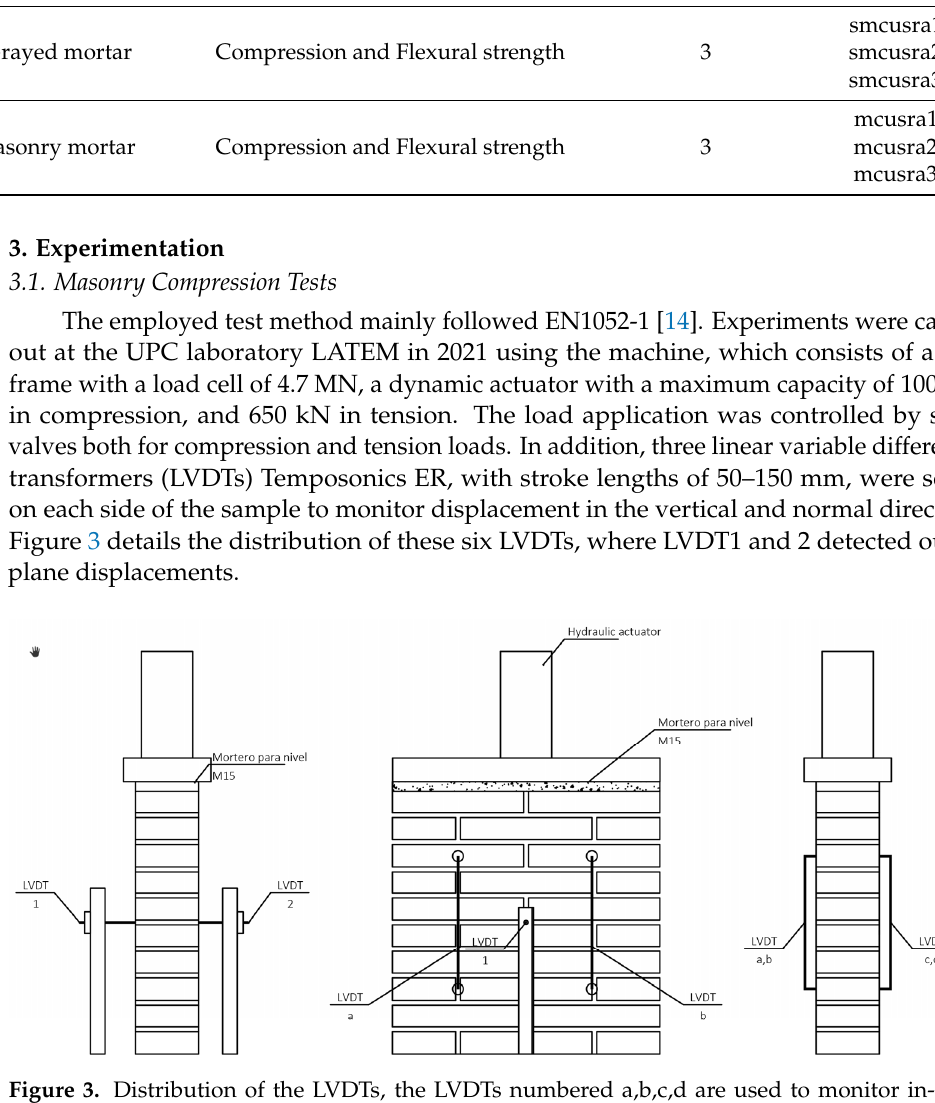
Figure 3. Distribution of the LVDTs, the LVDTs numbered a,b,c,d are used to monitor in-plane displacements, and the LVDTs numbered 1, 2 are used to monitor out-of-plane displacements. The load cell had a circular shaped bearing end that did not correspond to the cross- section of the sample. Therefore, a steel bearing with a thickness of 30 mm and a wooden plate with a thickness of 10 mm were used to carry the load evenly. To remove the adverse